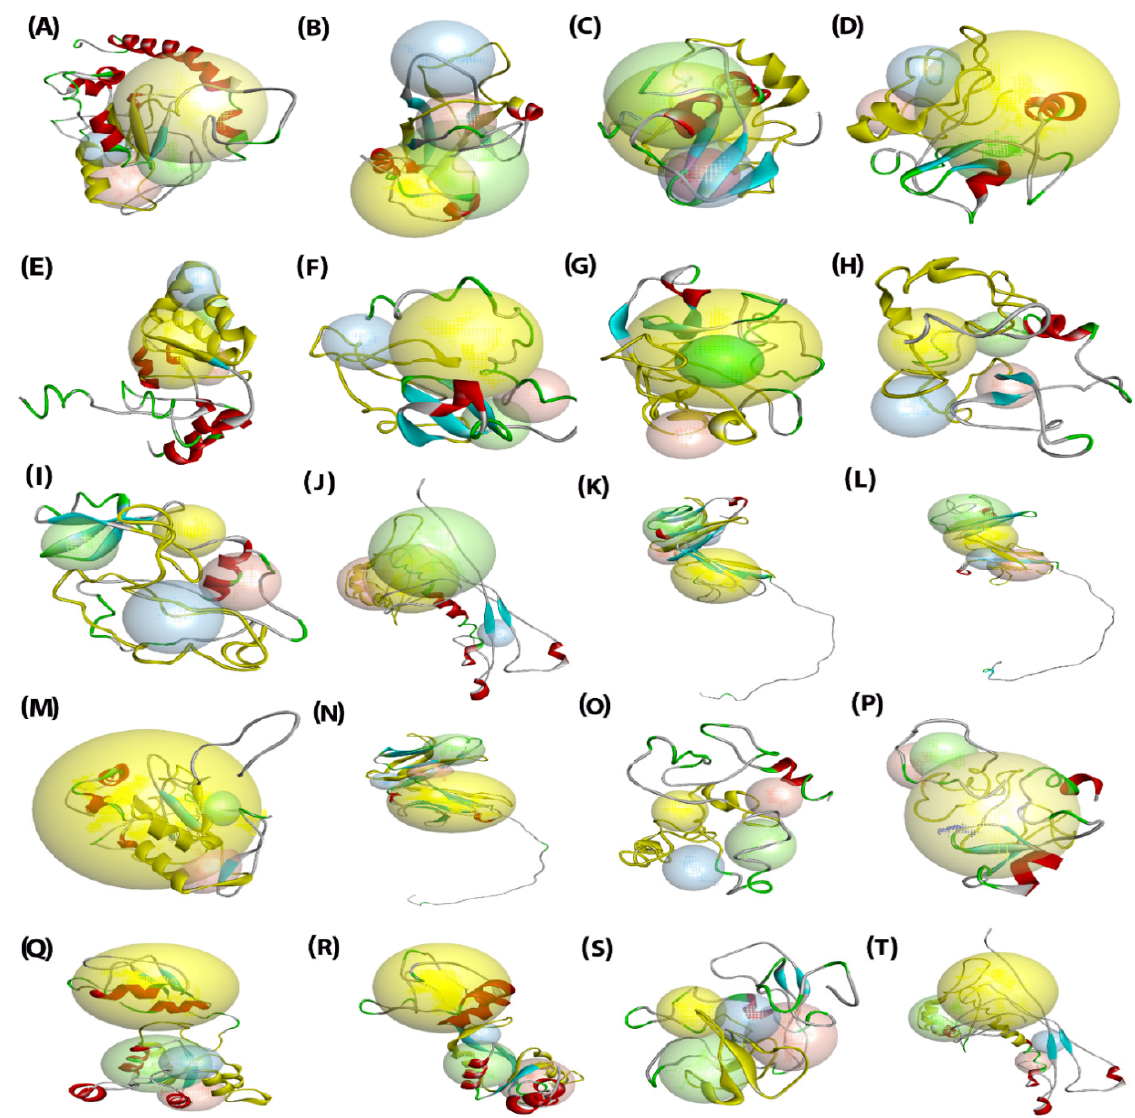
Figure 5. The final 3D modeled structures of SlPLATZ proteins generated using Discovery Studio v.21.1. The components of secondary structure: α -helices (red), β -sheets (cyan), coils (green), and loops (gray) and the four binding sites: site 1 (yellow sphere), site 2 (green sphere), site 3 (red sphere), and site 4 (blue sphere), are displayed in the predicted 3D structures of (A) SlPLATZ1 − (T) SlPLATZ20.